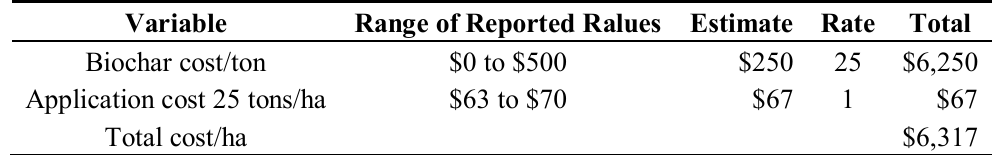
Table 1. Range and practical estimate of the total cost/ha of biochar soil application